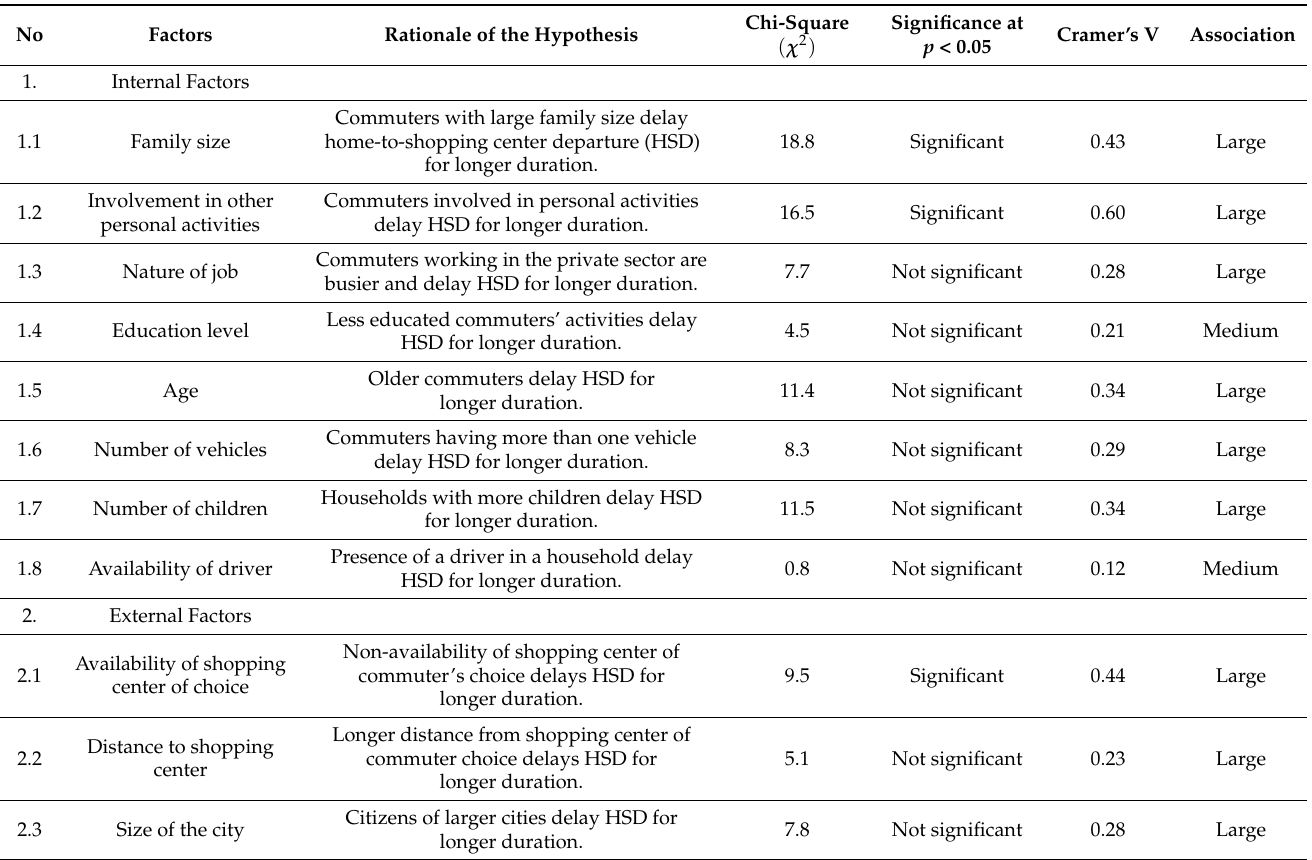
Table 2. Hypothesis and the level of association between D F and D D